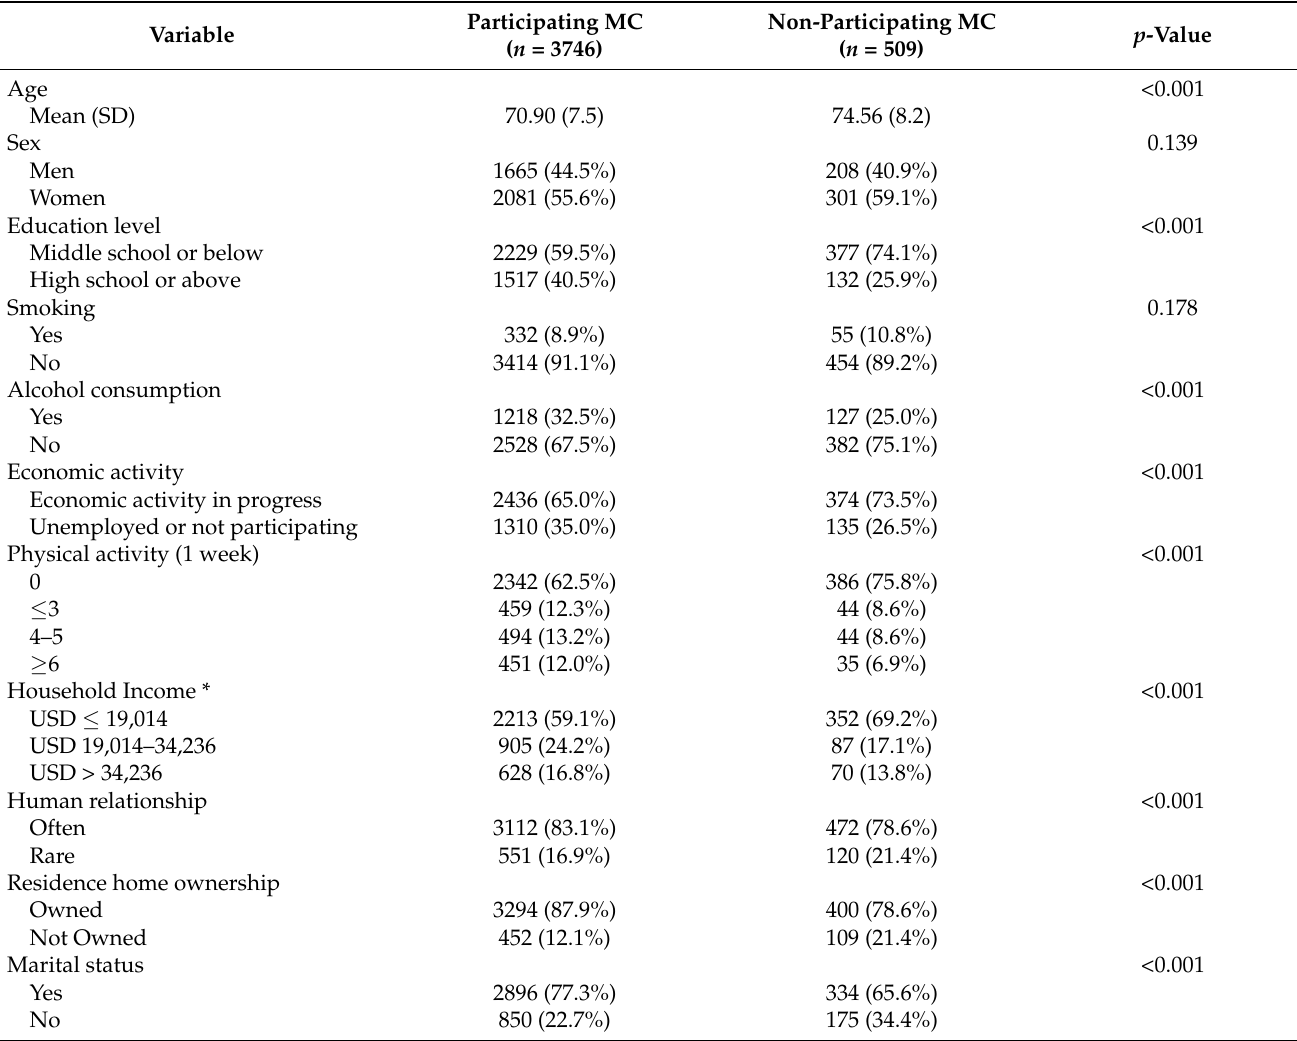
Table 2. Baseline characteristics of participants by medical check-up (MC).